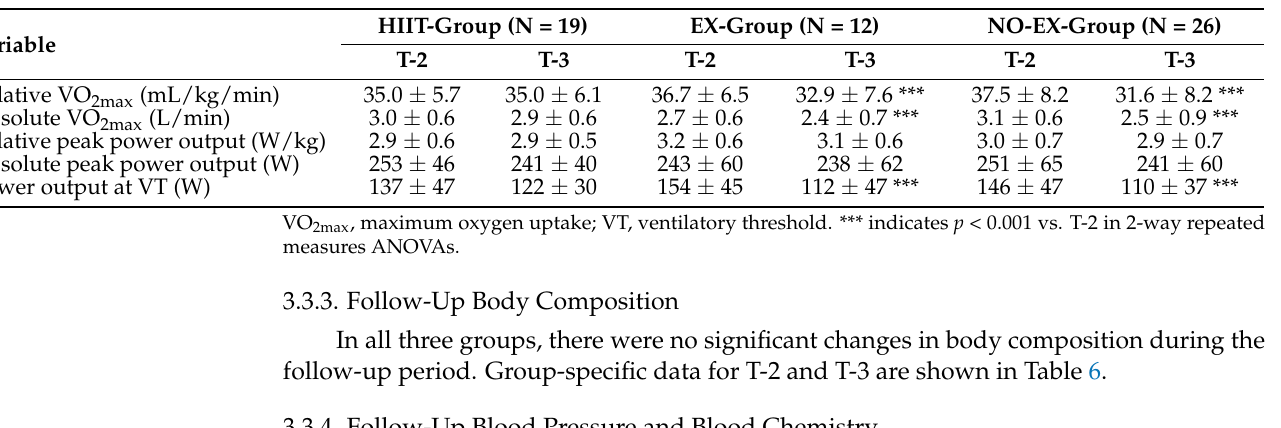
Table 5. Mean values and standard deviations (SD) of participants’ (N = 57) cardiorespiratory fitness data at post-intervention (T-2) and follow-up